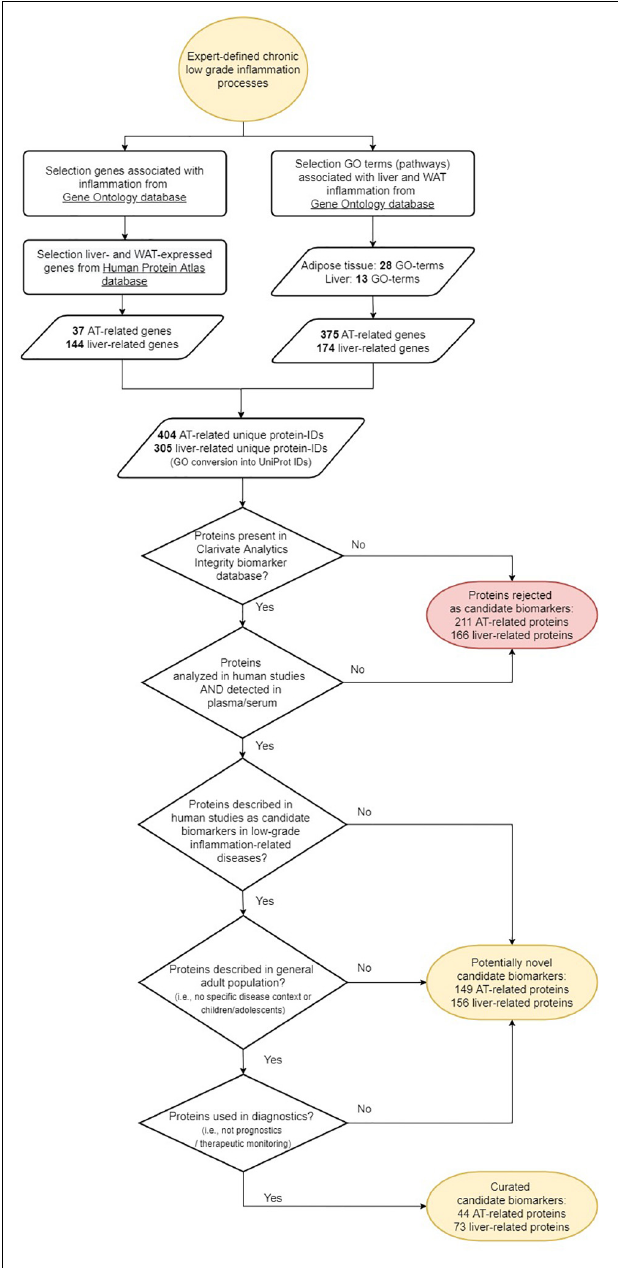
FIGURE 1 | Workflow of the selection of candidate protein biomarkers for tissue inflammation of liver and/or adipose tissue.